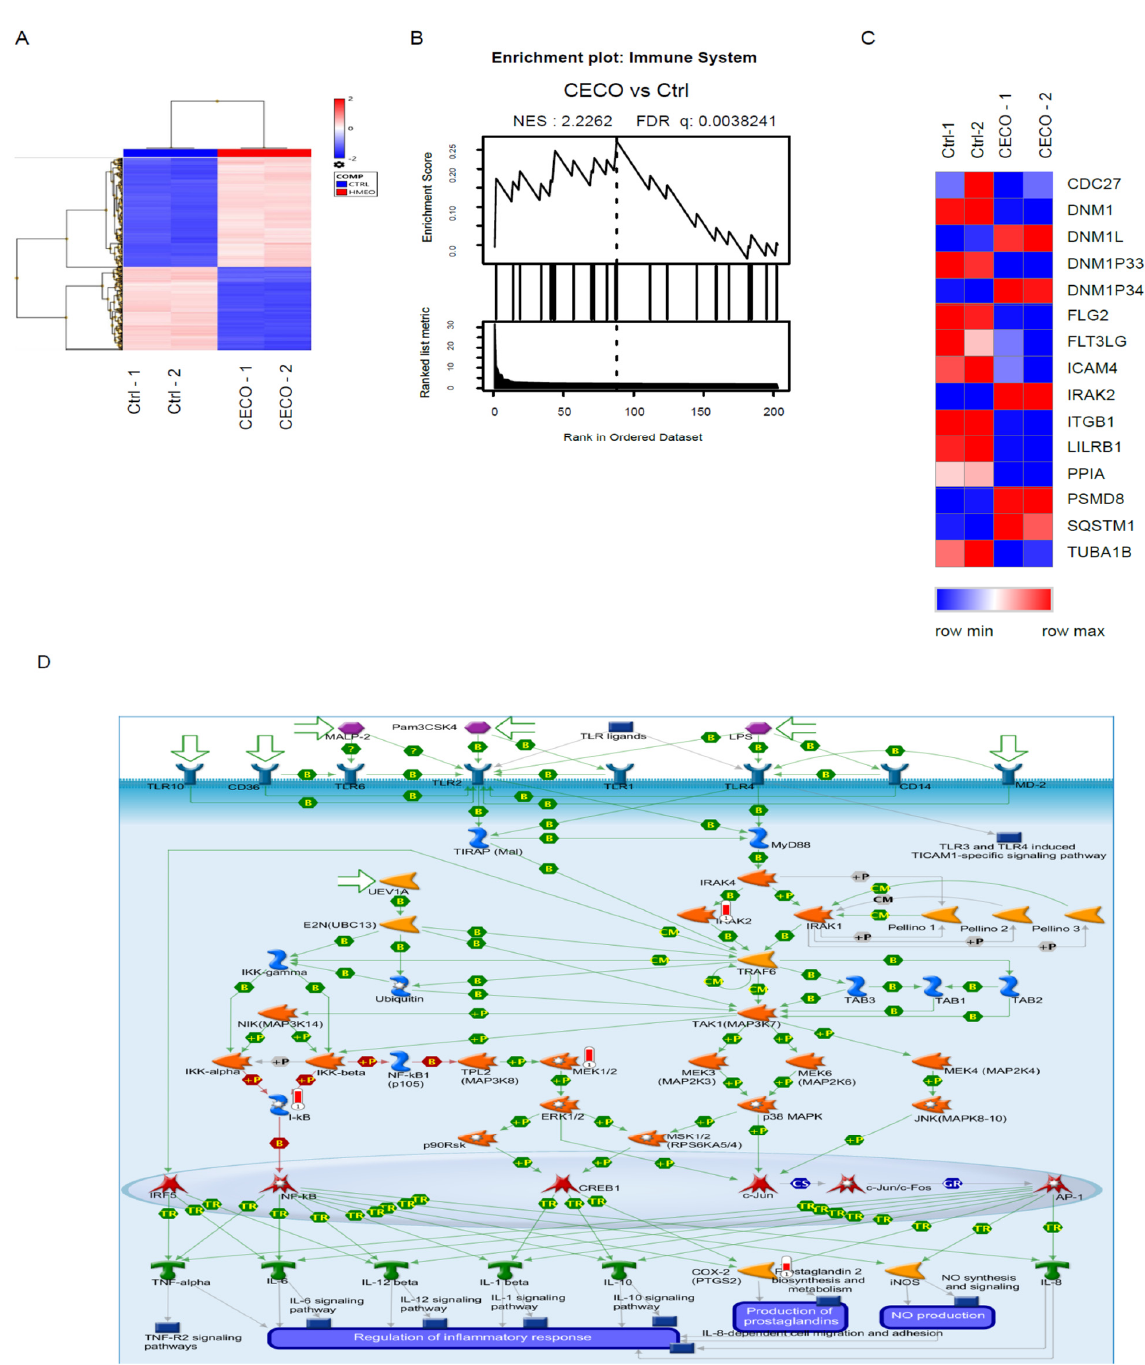
Figure 4. The Canonical process networks and signaling pathways in macrophages significantly modulated by colostrum exosome encapsulated oligosaccharides. The hierarchical cluster of significantly changed genes in macrophages modulated by colostrum exosome encapsulated oligosaccharides ( A ). The significantly changed genes in macrophages modulated by colostrum exosome encapsulated oligosaccharides were enriched in immune system function, as accessed by GSEA (Enrichment Score (ES)), Normalized Enrichment Score (NES), False Discovery Rate (FDR) ( B ). Heat maps comparing expression of significantly genes that involving immune system function (3-fold cutoff, p < 0.001) ( C ). Colors represent genes up-regulated (red) and down-regulated key genes (blue). The scored network of “Immune response_TLR2 and TLR4 signaling pathways” modulated by colostrum exosome contained oligosaccharides on macrophages ( D ). It is based on the enrichment distribution sorted by ‘Statistically significant Maps’ set. Related experimental data is linked to and visualized on the maps as thermometer-like figures. Upward thermometers have red color and indicate significantly up-regulated signals and downward (blue) ones indicate down-regulated expression levels of the genes.